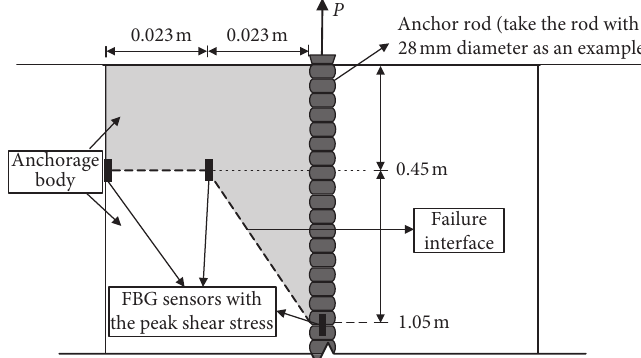
Figure 17: Positions of the FBG sensors with the peak shear